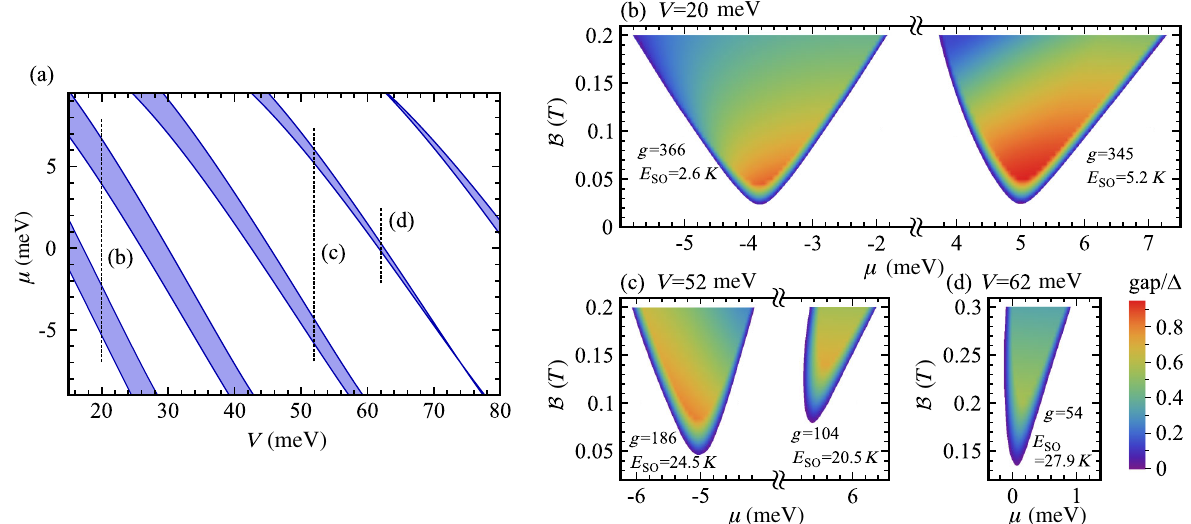
FIG. 6. (a) Windows of chemical potential (cid:1) (blue regions) in which the gate-defined wire exhibits an odd number of channels, assuming a voltage drop U ¼ 0 : 05 V and perpendicular magnetic field B ¼ 0 : 15 T . The horizontal axis denotes the confinement depth V defining the wire. Inside of these windows, introducing proximity-induced superconductivity yields a topological phase supporting Majorana zero modes at the wire’s ends. (b)–(d) Phase diagrams in the B (cid:1) (cid:1) plane along the constant- V cuts labeled by dashed lines in (a). Shaded areas denote topological phases, with the bulk gap (in units of the pairing energy (cid:3) ¼ 0 : 25 meV ) indicated by the color scale. For each topological region, we also display the topmost partially occupied subband’s effective g factor and spin- orbit energy—both of which are quite large in all